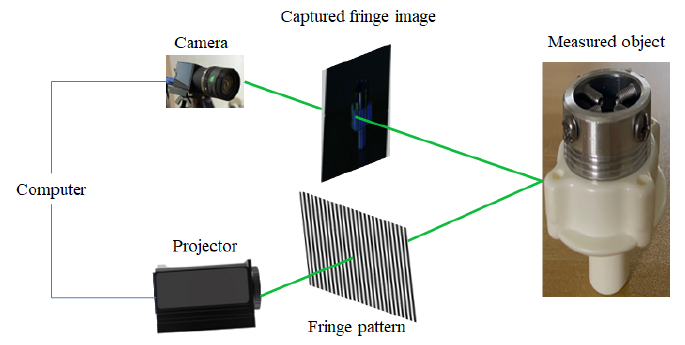
Figure 6. Schematic of the experimental setup.